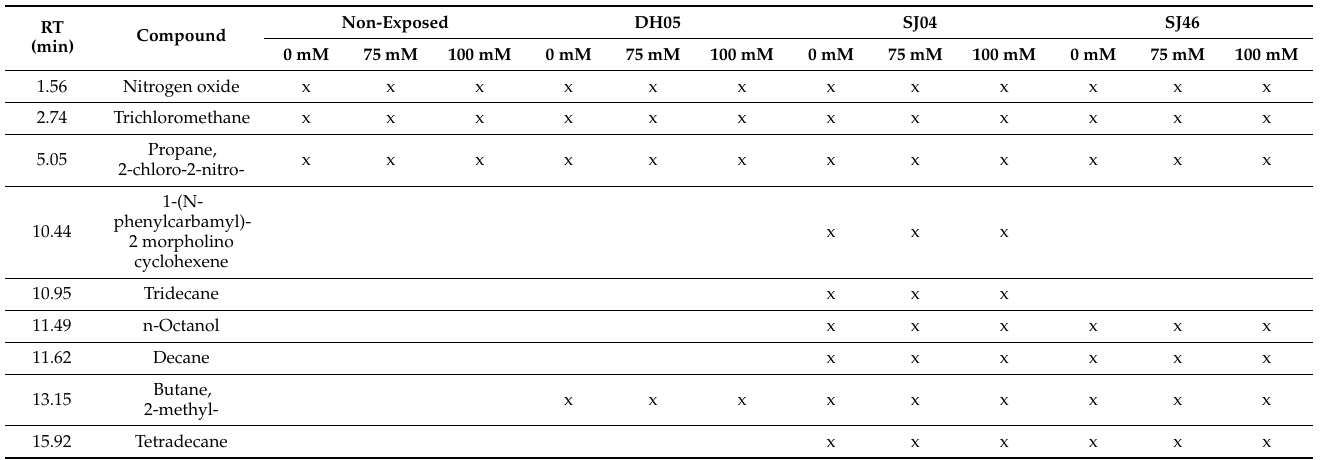
Table 2. Identification of major chemical signals detected in mVOCs, based on GC–MS analysis and comparison with the NIST database, with acceptance of SI ≥